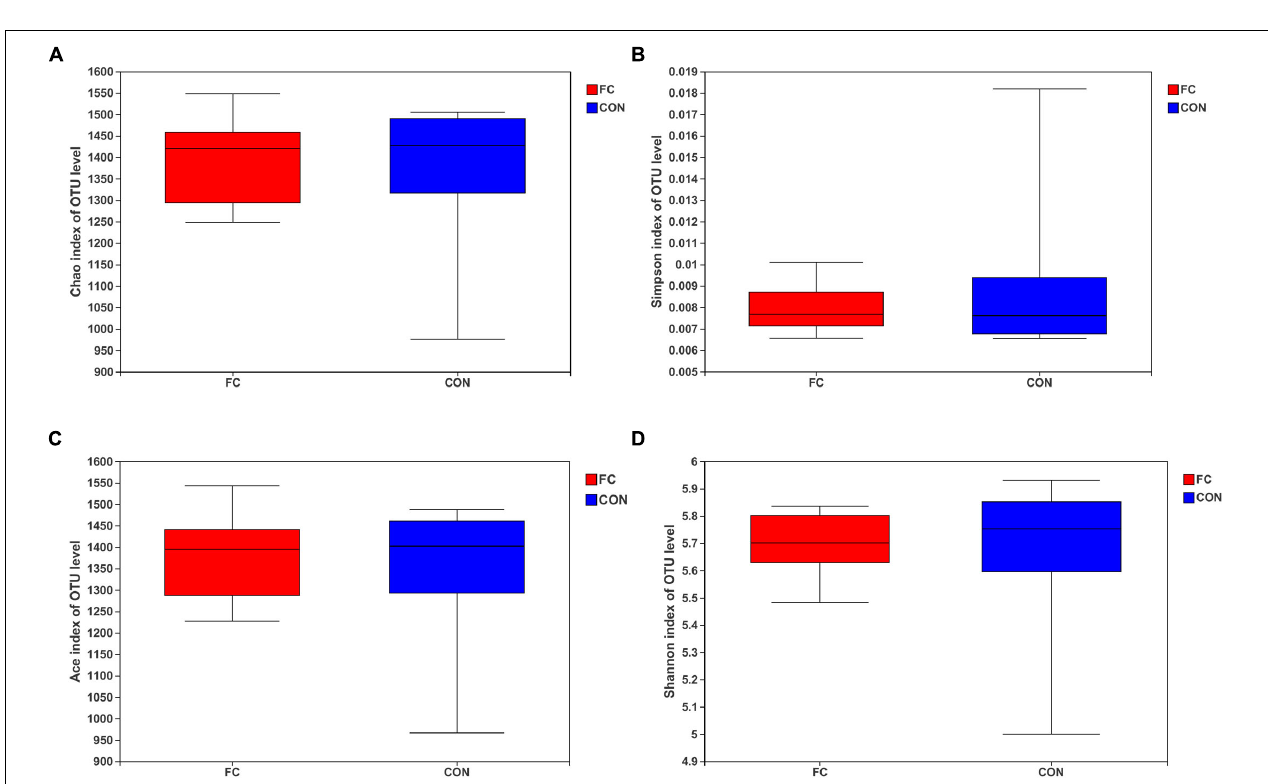
FIGURE 2 | Alpha diversity for the fecal microbiota in follicular cyst and normal follicle ewes. (A) Chao index; (B) Simpson index; (C) ACE index; (D) Shannon